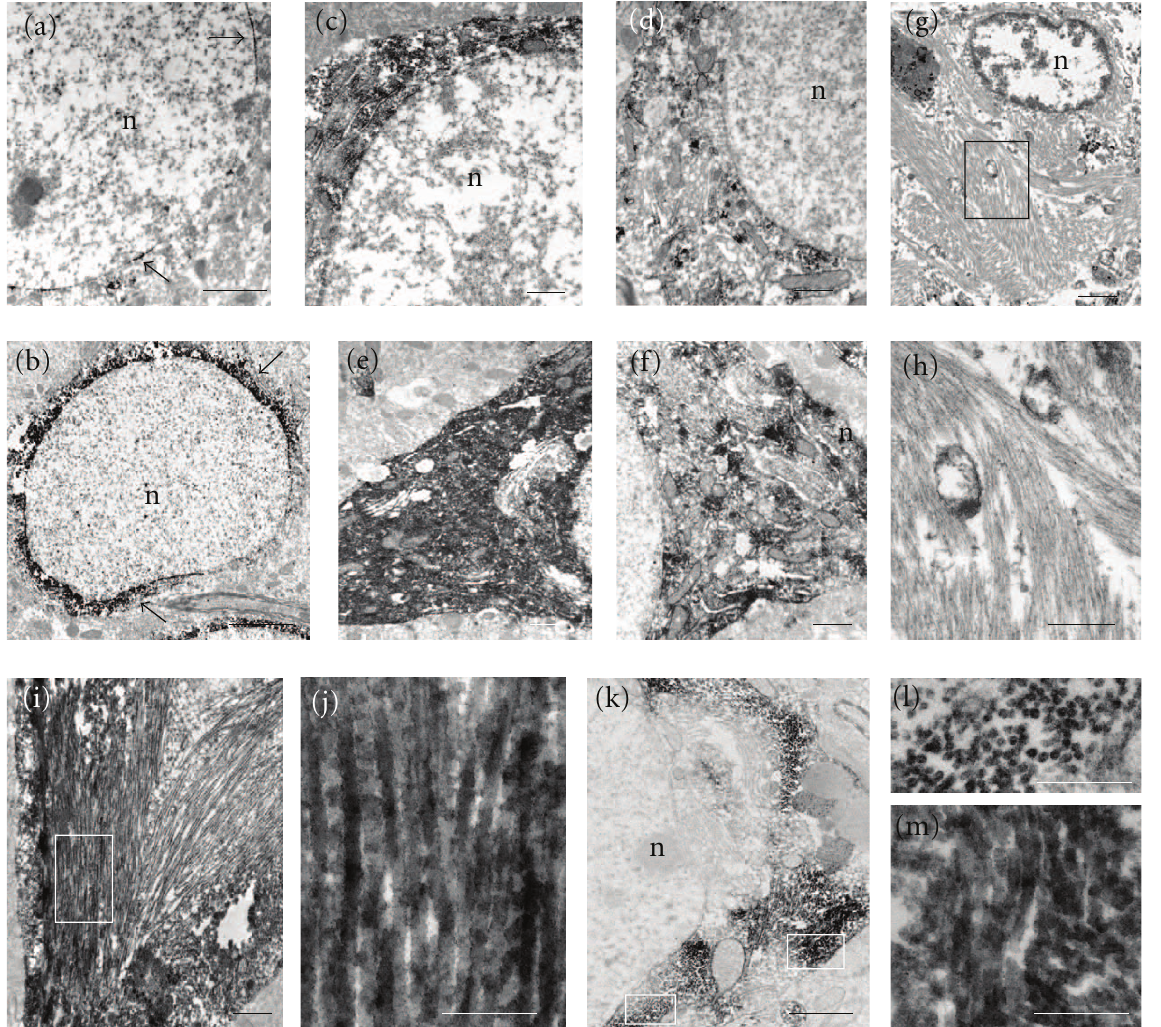
Figure 14: Electron photomicrographs showing perinuclear and cytoplasmic 6E10 immunoreactivity (black arrows) in hippocam- pal/subicular complex neurons at 2- (a) and 9- (b) month-old 3xTg-AD mice. Micrographs showing scattered Alz50 (c) and AT8 (d) immunoreactivity in hippocampal/subicular complex neurons in 2-month-old 3xTg-AD mice, whereas at 9 months Alz50 (e) and AT8 (f) immunoreactivity was increased, without the formation of filaments as seen in AD (g). Boxed area shows a higher-magnification photograph of the morphology of paired helical filaments in the AD brain (h). Photomicrographs of Alz50 ((i) and (j)) and AT8-ir ((k)–(m)) filaments in hippocampal/subicular complex neurons at 23 months in the 3xTg-AD mouse. J, Panel shows detail of straight Alz50-ir filaments from the white boxed area in (i). (l) and (m) areas containing AT8-ir filaments are outlined in white in panel k showing AT8 positive filaments in cross (l) and longitudinal (m) profile. Abbreviation: n: nucleus. Scale bars in (a), (b), (g) = 2 μ m, (c), (d), (f), (k) = 1 μ m, (e), (i), (h) = 0.5 μ m and (j), (l), (m) = 200